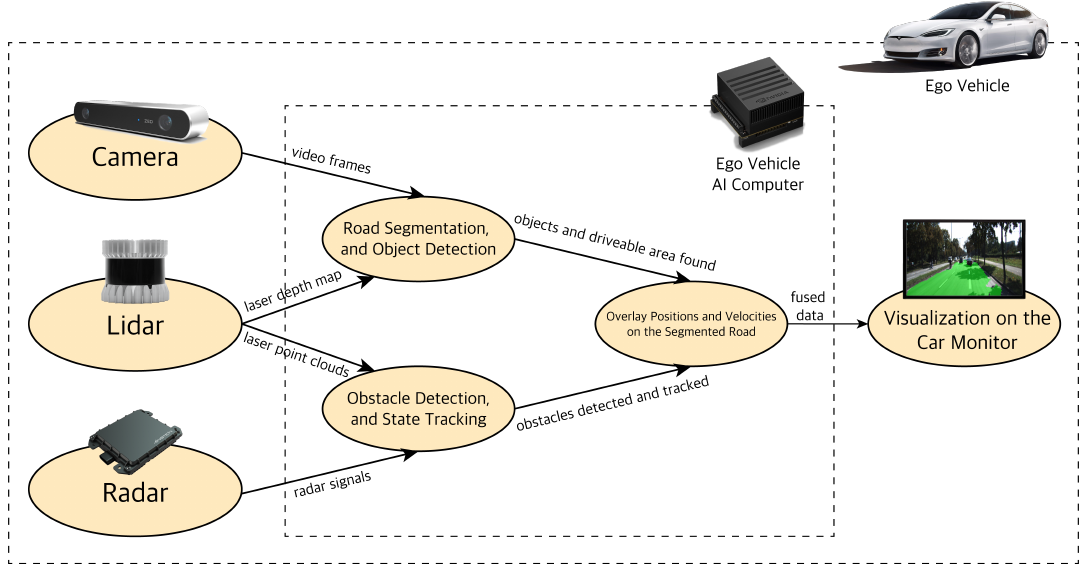
Figure 6. Multi-sensor fusion algorithm